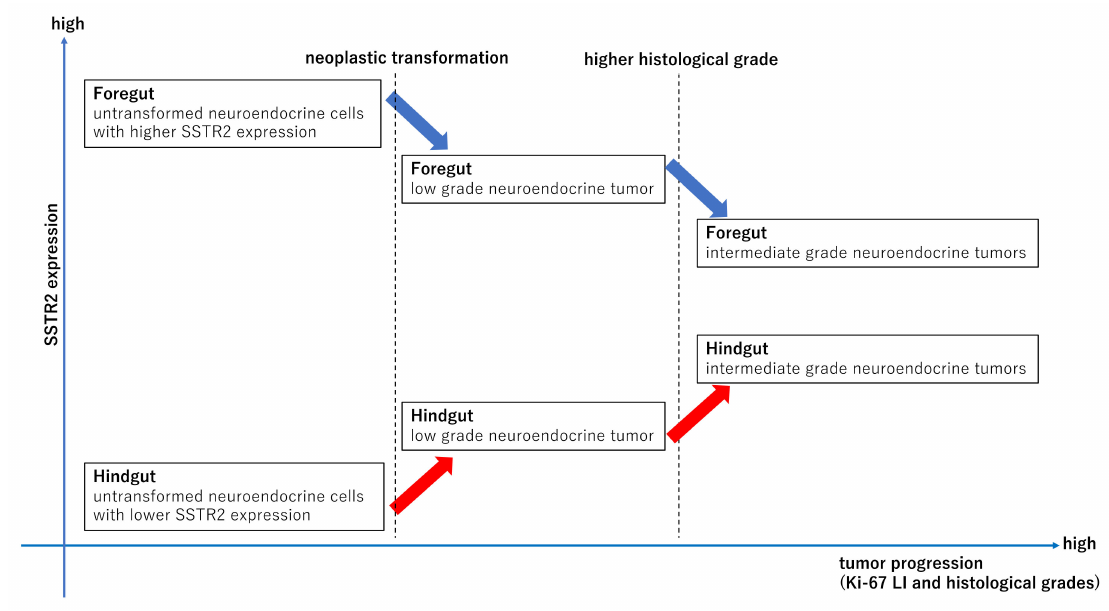
Figure 6. We hypothesized that low grade foregut NETs, derived from their normal counterparts which harbor relatively abundant SSTR2 expression, could have high SSTR2 expression, while foregut NETs with more deviation from their normal counterparts and higher histological grades could have lower SSTR2 expressions. In contrast, hindgut NETs derived from their normal counterparts which harbor intrinsically low SSTR2 expression demonstrated low SSTR2 expression, while hindgut NETs with more deviations from their normal counterparts and higher histological grades had higher SSTR2